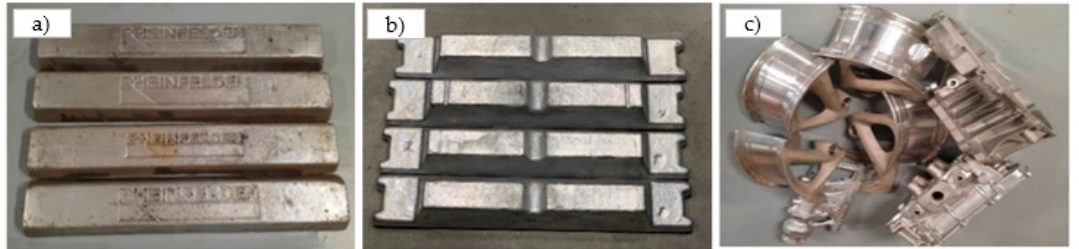
Figure 1. Raw aluminium materials used for the experiment: ( a ) primary AlSi10MnMg ingots; ( b ) secondary AlSi10MnMg(Fe) ingots; ( c ) new scrap for secondary AlSi10MnMg(Fe) preparation.